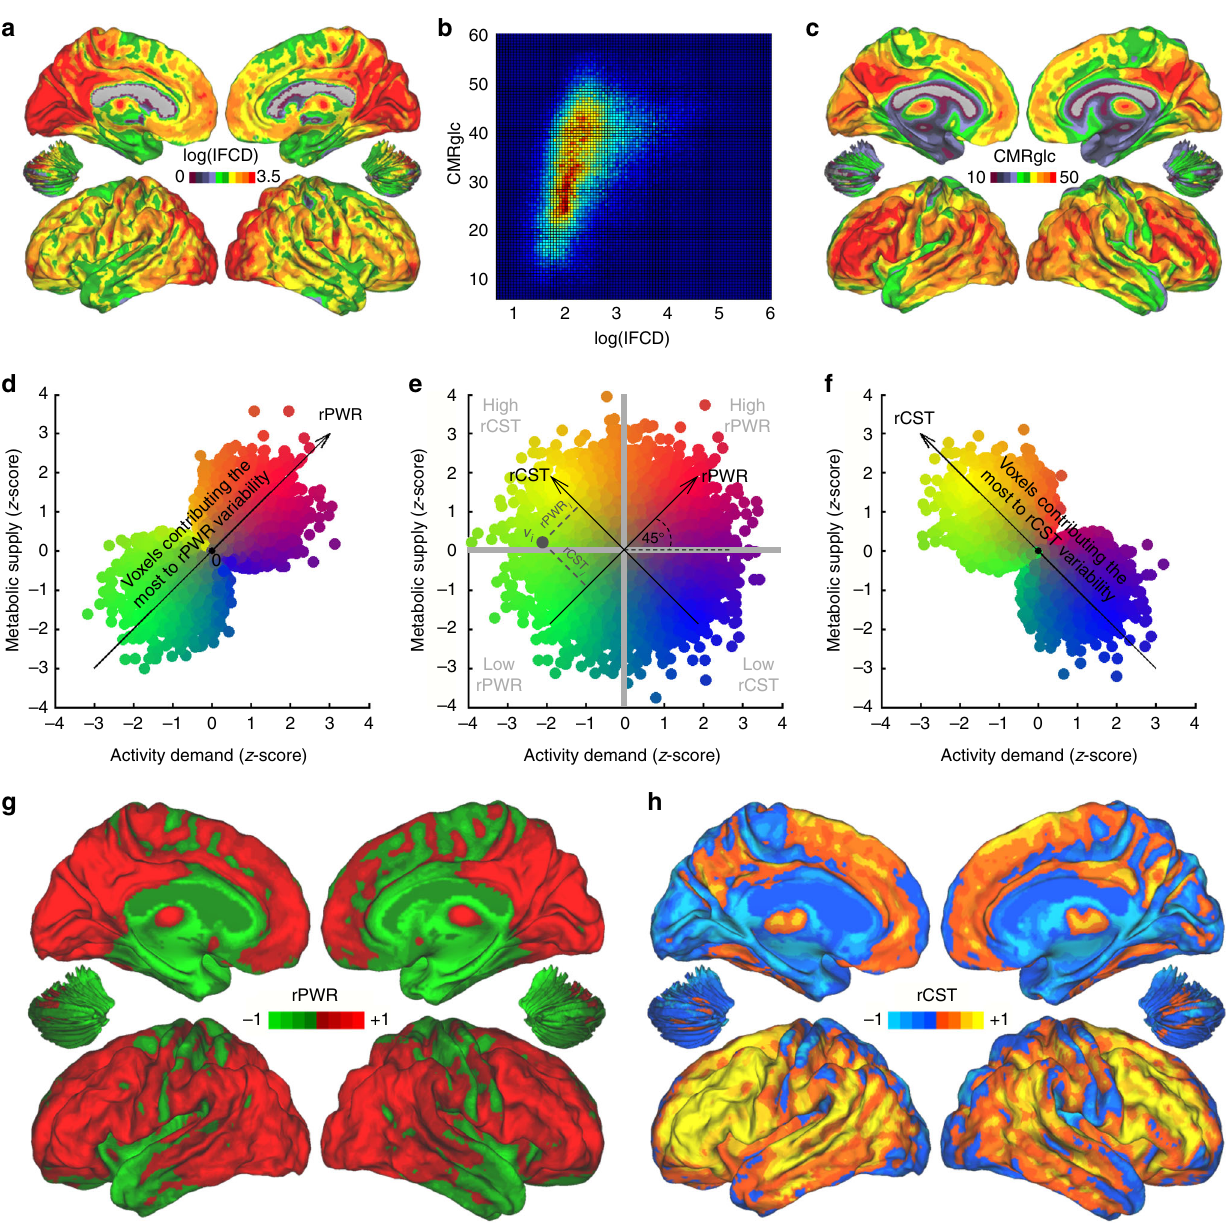
Fig. 1 Voxelwise relative power (rPWR) and relative cost (rCST) (cohort-1, n = 28). a Average logarithm of local functional connectivity density (log(lFCD)) map for cohort-1 ( n = 28) subjects highlighting precuneus and visual cortex as the most locally connected regions. b COMET (connectivity-metabolism) map. A two-dimensional histogram of log(lFCD) versus cerebral metabolic rate of glucose (CMRglc) highlighting the frequency of log(lFCD) and CMRglc association pairs ( r = 0.44, p < 0.00001, 139,269 voxels). Red to blue indicate high to low-frequency counts, respectively. c Average CMRglc map highlighting precuneus and lateral frontal lobe as the most metabolically demanding regions. d – f rPWR and rCST were calculated by a π /4 (45°) rotation along (mean-variance normalized) log(lFCD) and CMRglc axes. e A hypothetical presentation of (mean-variance normalized) activity demand versus metabolic supply (not to be confused with part b shown without mean-variance normalization) with each circle representing one brain voxel. Yellow- colored voxels correspond to higher rCST, blue to lower rCST, red to higher rPWR, and green to lower rPWR. For a representative voxel v i (dark gray circle), rPWR i and rCST i are shown on the plot. For v i , rPWR is negative and rCST is positive. For visual demonstration purposes, voxels contributing the most to rPWR variability ( d ) and rCST variability ( f ) are highlighted. For this purpose, highlighting was performed by multiplying the radius of each voxel (in polar coordinate system) by its corresponding absolute rPWR ( d ) or absolute rCST ( f ). Group-average rPWR ( g ) and rCST ( h ) maps. Note the color scale in g resembles that used for the hypothetical voxels along the rPWR axis in d and the color scale in h resembles that used for the hypothetical voxels along the rCST axis in f . Also see Fig. 2 (and Supplementary Table 8) for regional (Fig. 1a, c). Regions with higher rPWR included major sections of parahippocampal gyrus, and ventral anterior and lateral nuclei of visual, parietal, and frontal cortices, putamen, caudate, and the thalamus had lower rPWR (Fig. 1g, Supplementary Table 1). medial – dorsal nucleus of the thalamus (Fig. 1g, Supplementary Many brain regions with higher rPWR had higher rCST (Fig. 1g, Table 1). Conversely, parts of the anterior and posterior cerebellar h). Higher rCST regions included inferior, middle, superior lobes, medial – frontal, and precentral gyri, hippocampus and frontal, precentral, and postcentral gyri, as well as insula,